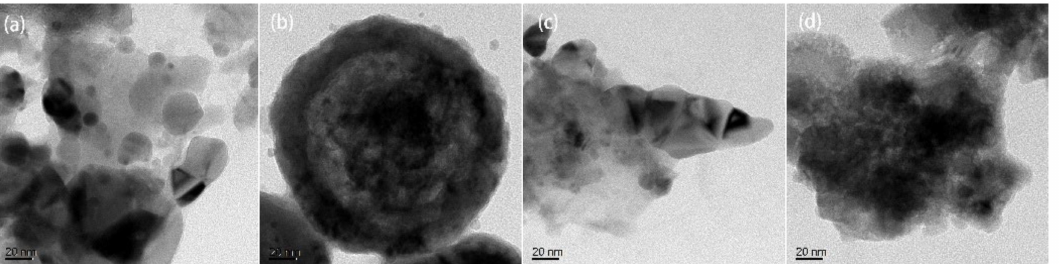
Figure 8. TEM images. ( a ) the fresh NC, ( b ) the used NC, ( c ) the fresh Zr 5 /NC, and ( d ) the used Zr 5